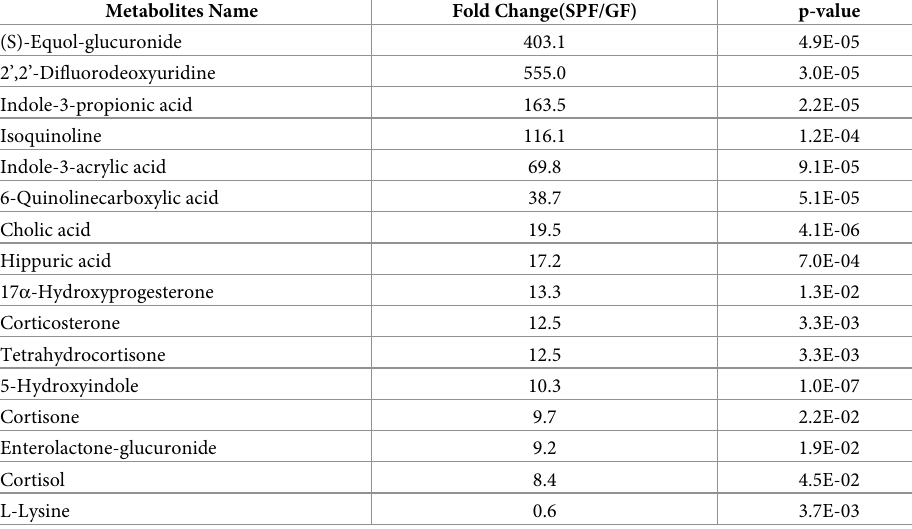
Table 3. Significantly transformed compounds in serum from 26 week-old ApoE -/-